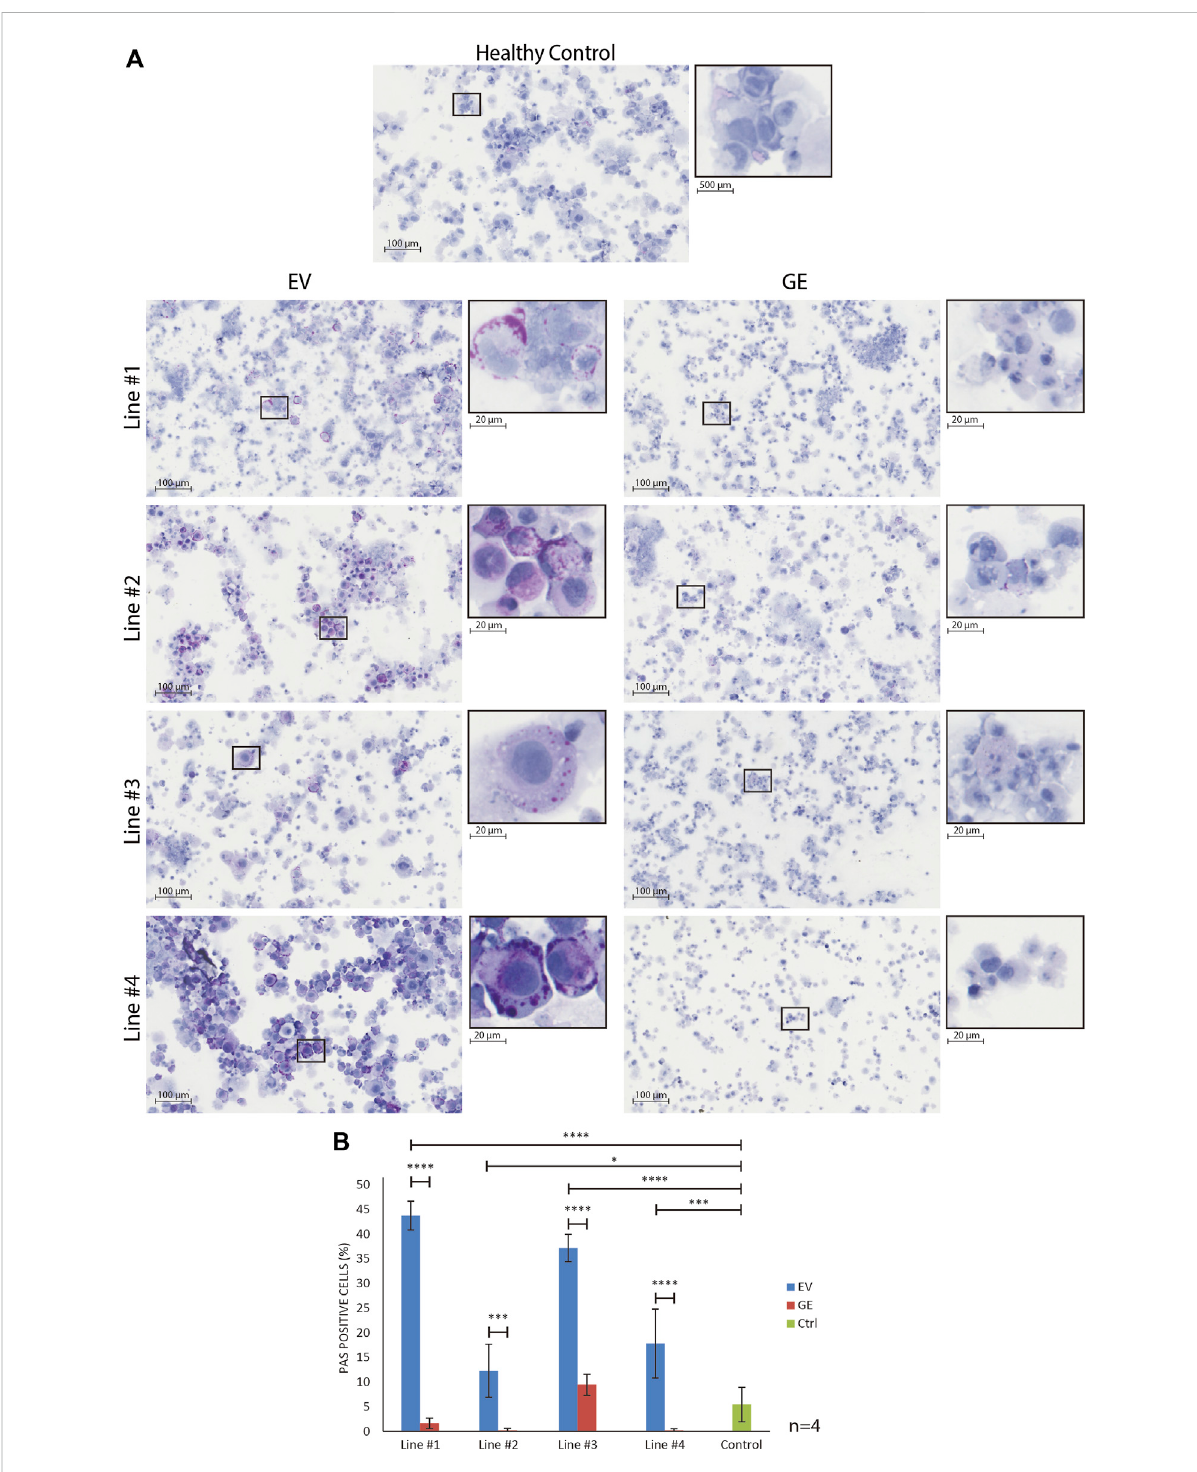
FIGURE 4 Normalizationofinclusionsaftergenecorrection. (A) periodicacid – Schiff(PAS)stainingofday14differentiatedchondrogeniccellsshowedthe accumulation ofinclusionsinEVcells,indicatedbytheincreaseofpurplesignal.Theinsertshowsahighermagni fi cationofselectedcellstovisualize the inclusions. (B) Quanti fi cation of PAS positive cells showed the normalization of inclusions after gene correction. Data represent means ± SD of 4 cytospins of independentcultures of chondrogeniccells. GE: Gene edited with ARSB cDNA , EV: Gene edited with empty vector control. Data are expressed as means ± SE. Statistical tests were performed with two-way ANOVA and Š ídák multiple comparisons correction, * p ≤ 0.05, *** p ≤ 0.001, **** p ≤